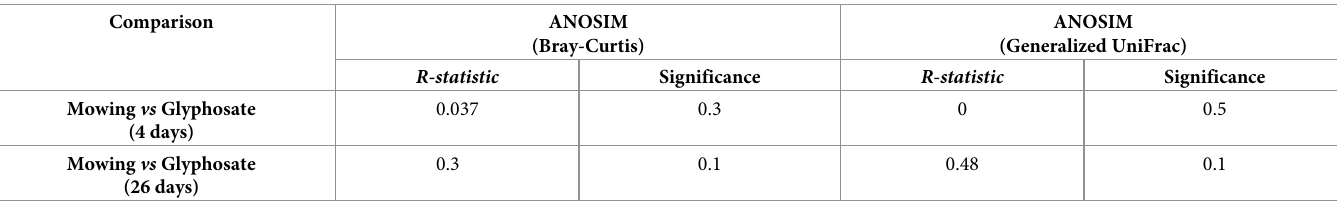
Table 4. Statistical comparison of the metabarcoding dataset between suppression methods at each sampling time. The result of analysis of similarities test (ANO- SIM) is indicated.